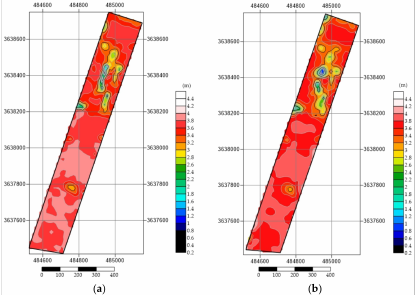
Figure 7. ( a ) Actual coal thickness distribution and ( b ) predicted coal thickness distribution.